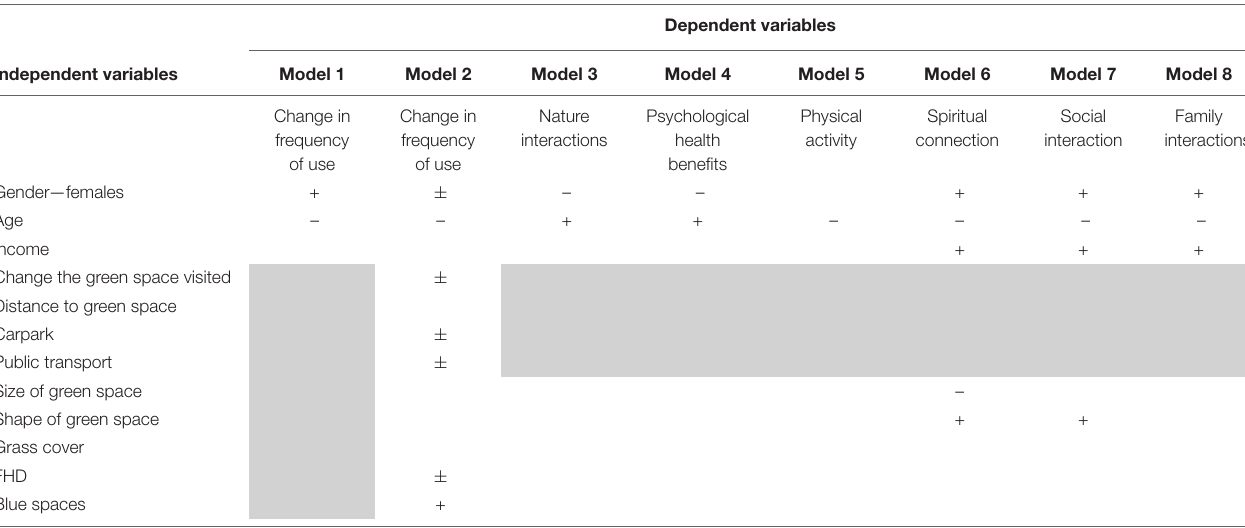
TABLE 3 | Significant associations between dependent and independent variables of eight regression models including sociodemographic and green space characteristics of green spaces used before (Model 1–2) and during (Model 3–8) a COVID-19 lockdown.